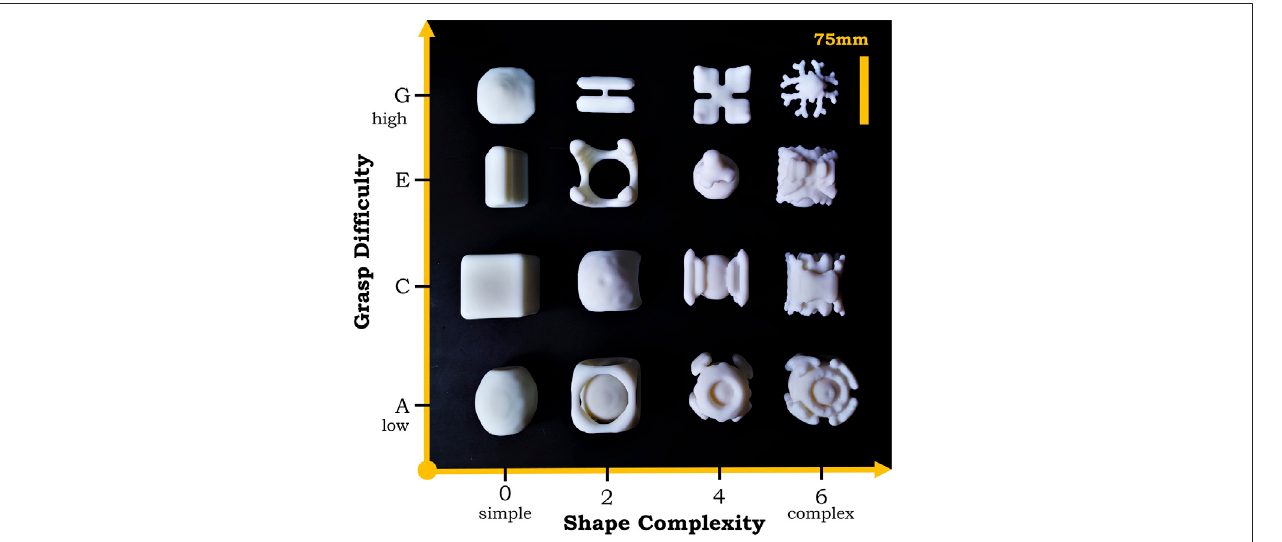
FIGURE 5 | The 16 models selected from the Evolved Grasping Analysis Dataset (EGAD) that are challenging to pick in terms of grasp dif fi culty in the vertical axis and shape complexity in the horizontal axis. The models in this image are the speci fi c 3D printed parts used in our experiments.